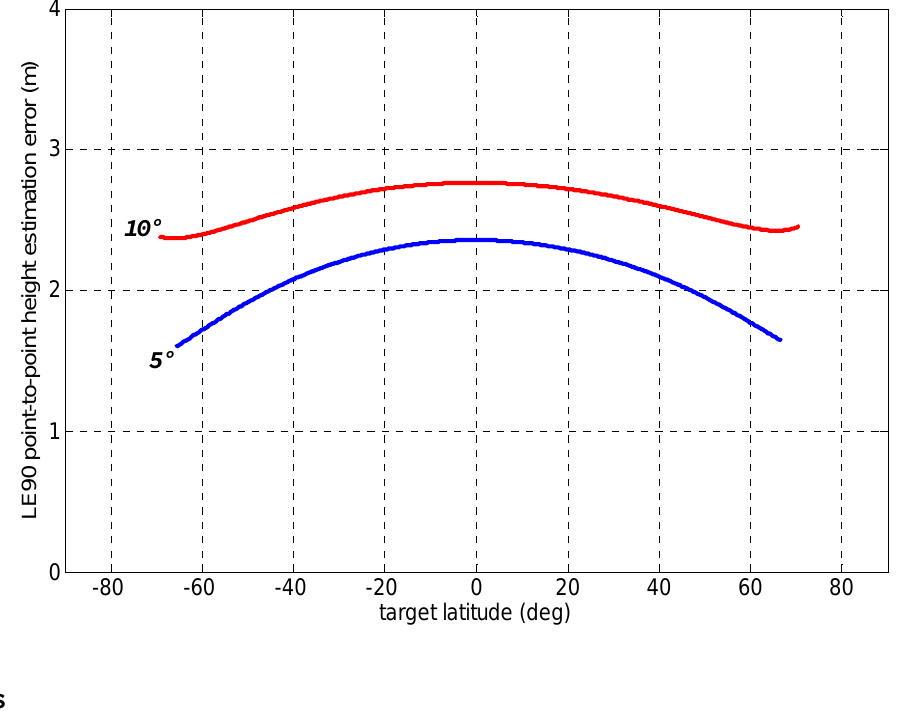
Figure 14. Height estimation error (LE90 point-to-point) as a function of target latitude for bistatic rigorous stereo SAR problem and low bistatic off-nadir angles (1/10 of an image pixel assumed as co-registration uncertainty, 0.25 m as uncertainty for monostatic antenna position error, and 0.1 m as baseline component measurement